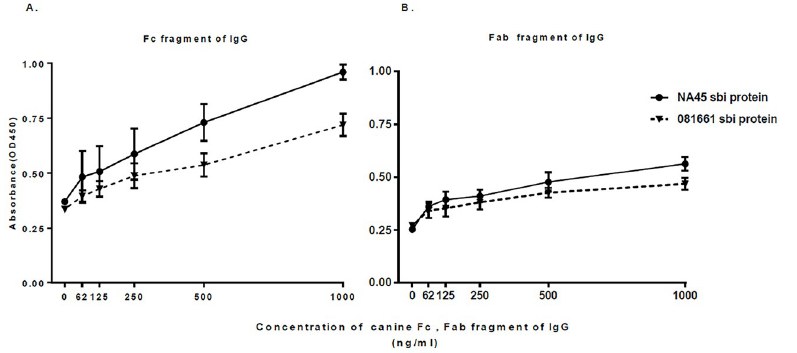
Fig 4. The association of immobilized Sbi recombinant protein with IgG fractions determined by ELISA. Sbi bound Fc (panel A) and Fab (panel B) fragments of canine IgG. Significantly more binding occurred with prSbi from NA45 than from 081661 (p = 0.0271). Reactivity with all concentrations was significantly different compared to the negative control (buffer) (p < 0.05) except for 62ng/ml and125ng/ml (Ns). Sbi proteins of strains NA45 and 081661 bound canine, equine, and feline IgG p < 0.0001 but did not significantly bind bovine IgG compared with the buffer control. The binding of Sbi proteins with canine IgG was higher than with feline IgG and equine IgG p < 0.05 (Fig 5A).